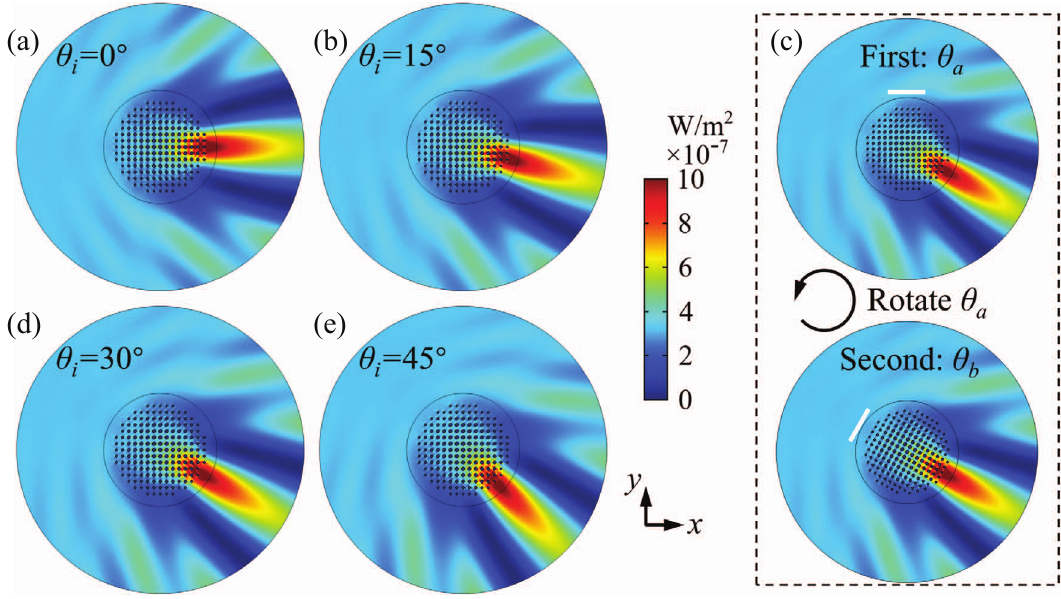
Figure 4. (a) – (d) Wave intensity fi eld of acoustic wave focusing when the incident angles h i are 0 (cid:1) , 15 (cid:1) , 30 (cid:1) and 45 (cid:1) . (e) Rotation correction procedure of square-lattice Luneburg